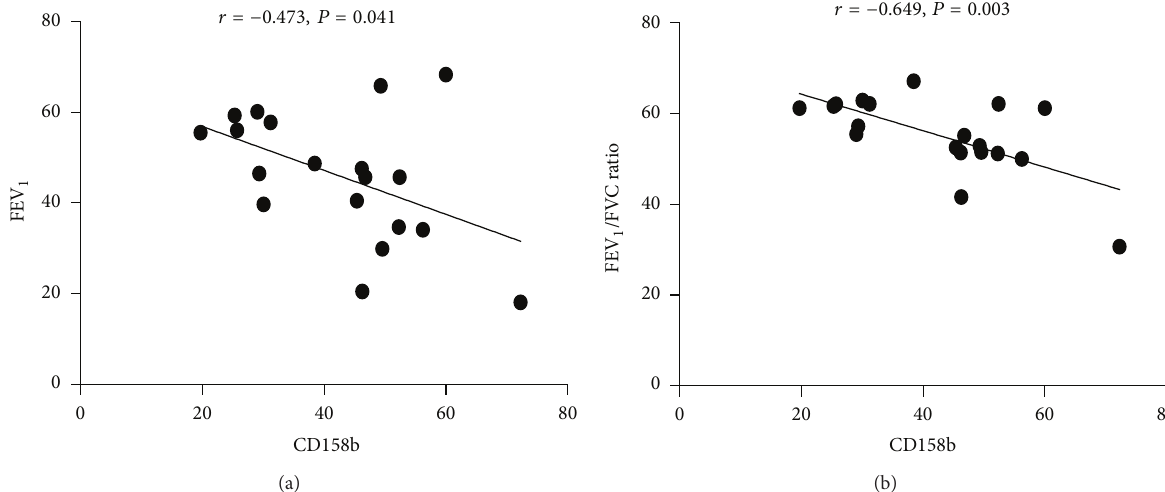
Figure 4: The correlation between FEV 1 , FEV 1 /FVC ratio and the frequency of CD158b + NK cells in COPD patients. (a) The correlation between FEV 1 and the frequency of CD158b + NK cells. (b) The correlation between the FEV 1 /FVC ratio and the frequency of CD158b + NK